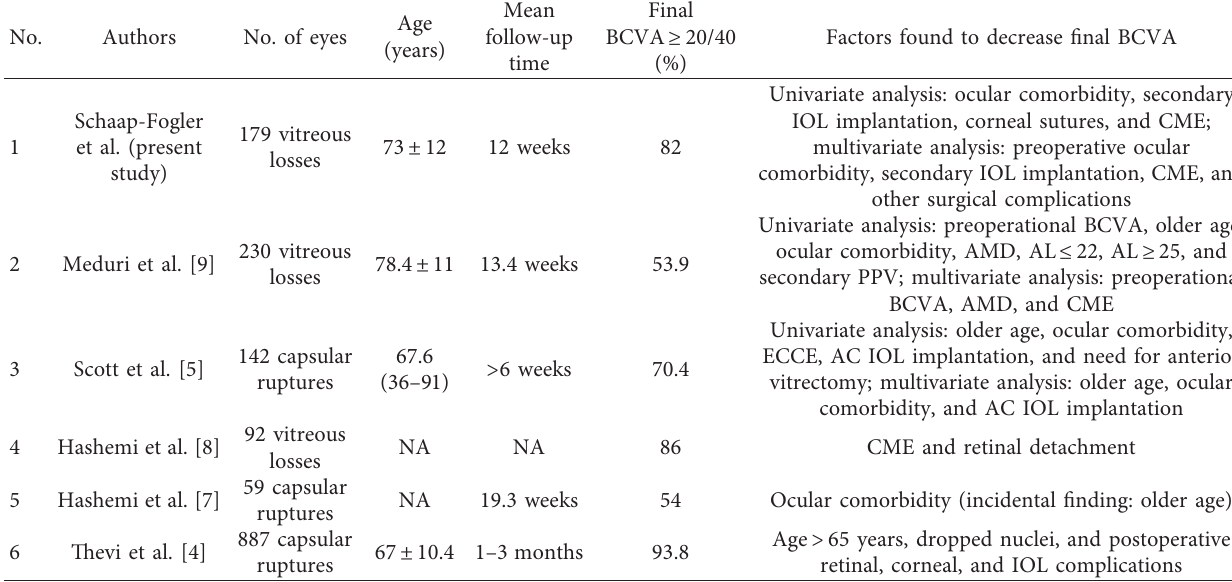
Table 4: Previous reports on prognostic factors for visual acuity outcome following vitreous loss during cataract surgery.